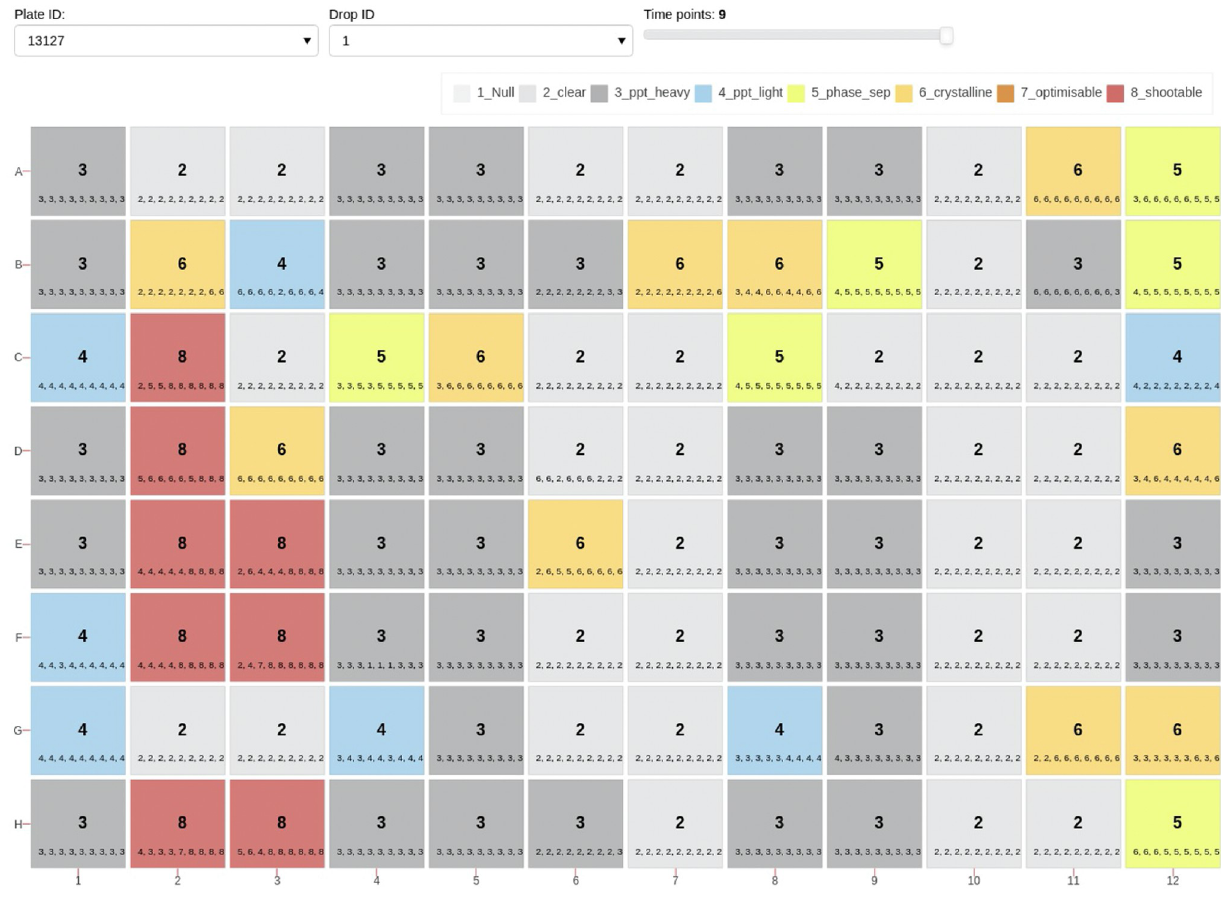
Fig 6. Visualisation of experimental outcomes obtained using the Morpheus crystallisation screen [4]. In addition to being labelled with the predicted class number, each well in the plate is colour-coded according to the predicted class. The sequence of numbers in small text for each well shows the class numbers predicted earlier in the time